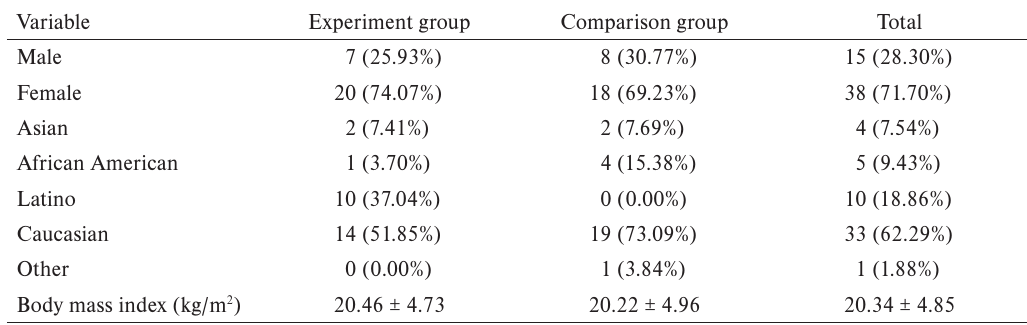
Descriptive statistics of the sample for gender, ethnicity (n/%), and body mass index (M ±